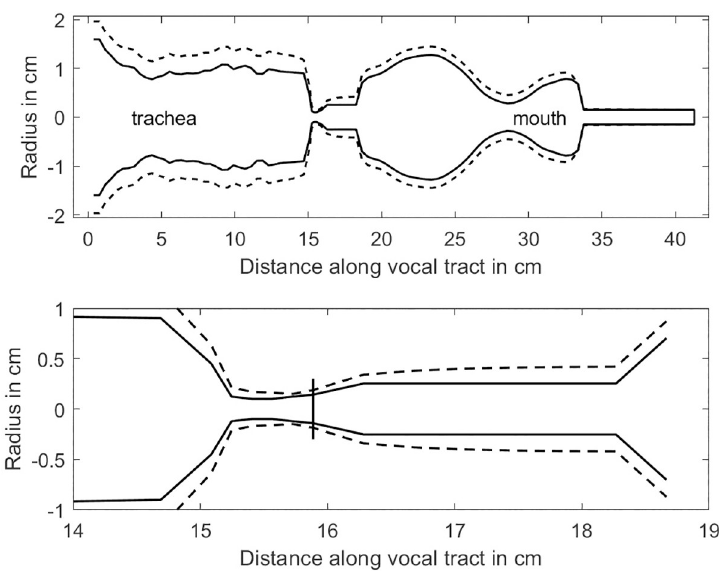
Fig 4. Expansion of the airway in a simulation model with a 3.0 mm diameter flow-resistant tube as an oral semi- occlusion and a lung pressure of 2.5 kPa. (top) entire airway, and (bottom) glottal and epilaryngeal airways